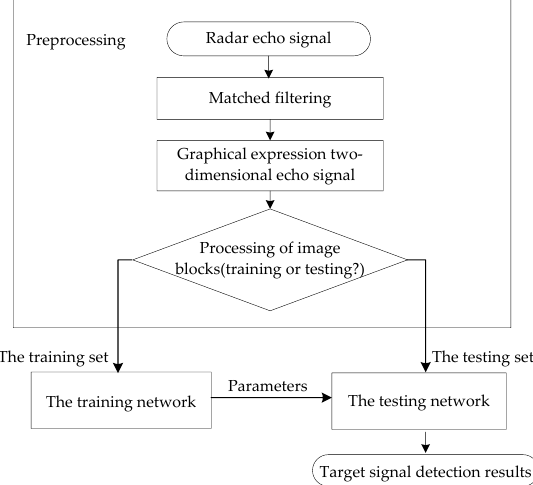
Figure 10. The flowchart of radar target signal detection in this paper. The simulation parameters of LFM are shown in the Table 2. Table 2. The simulation parameters of LFM. Parameters